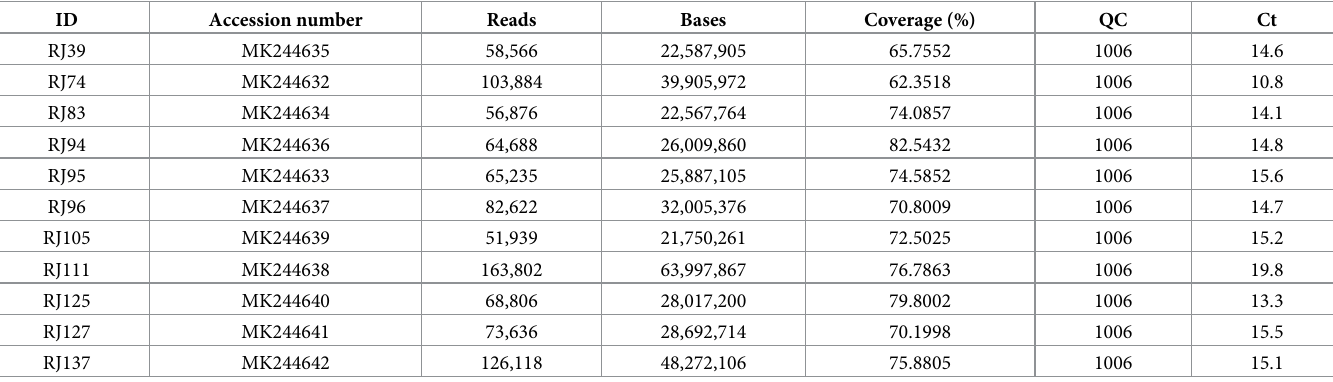
Table 2. Sequencing statistics for the 11 new obtained